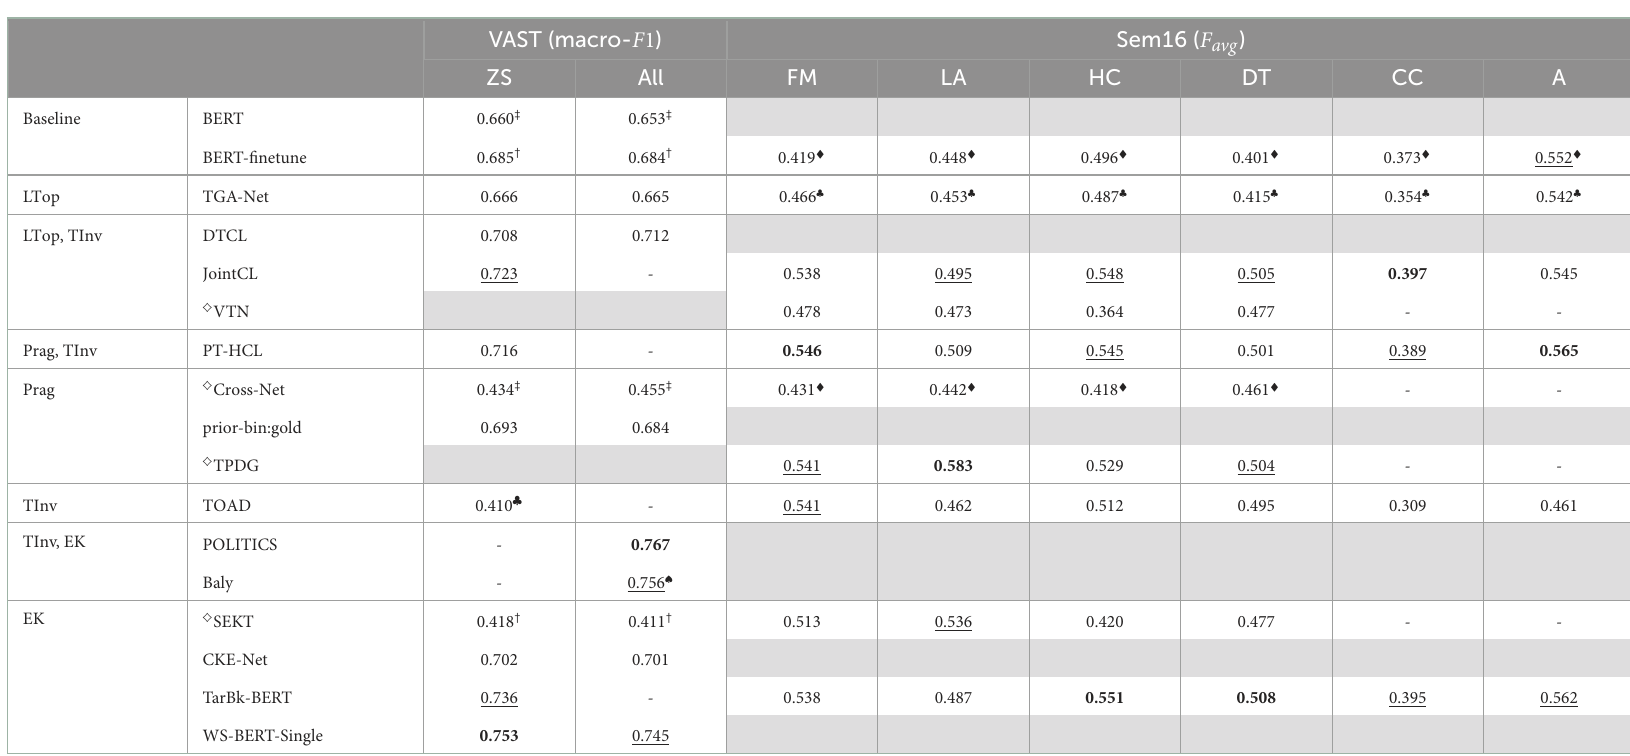
TABLE 2 ZSSD results for many-topic and few-topic